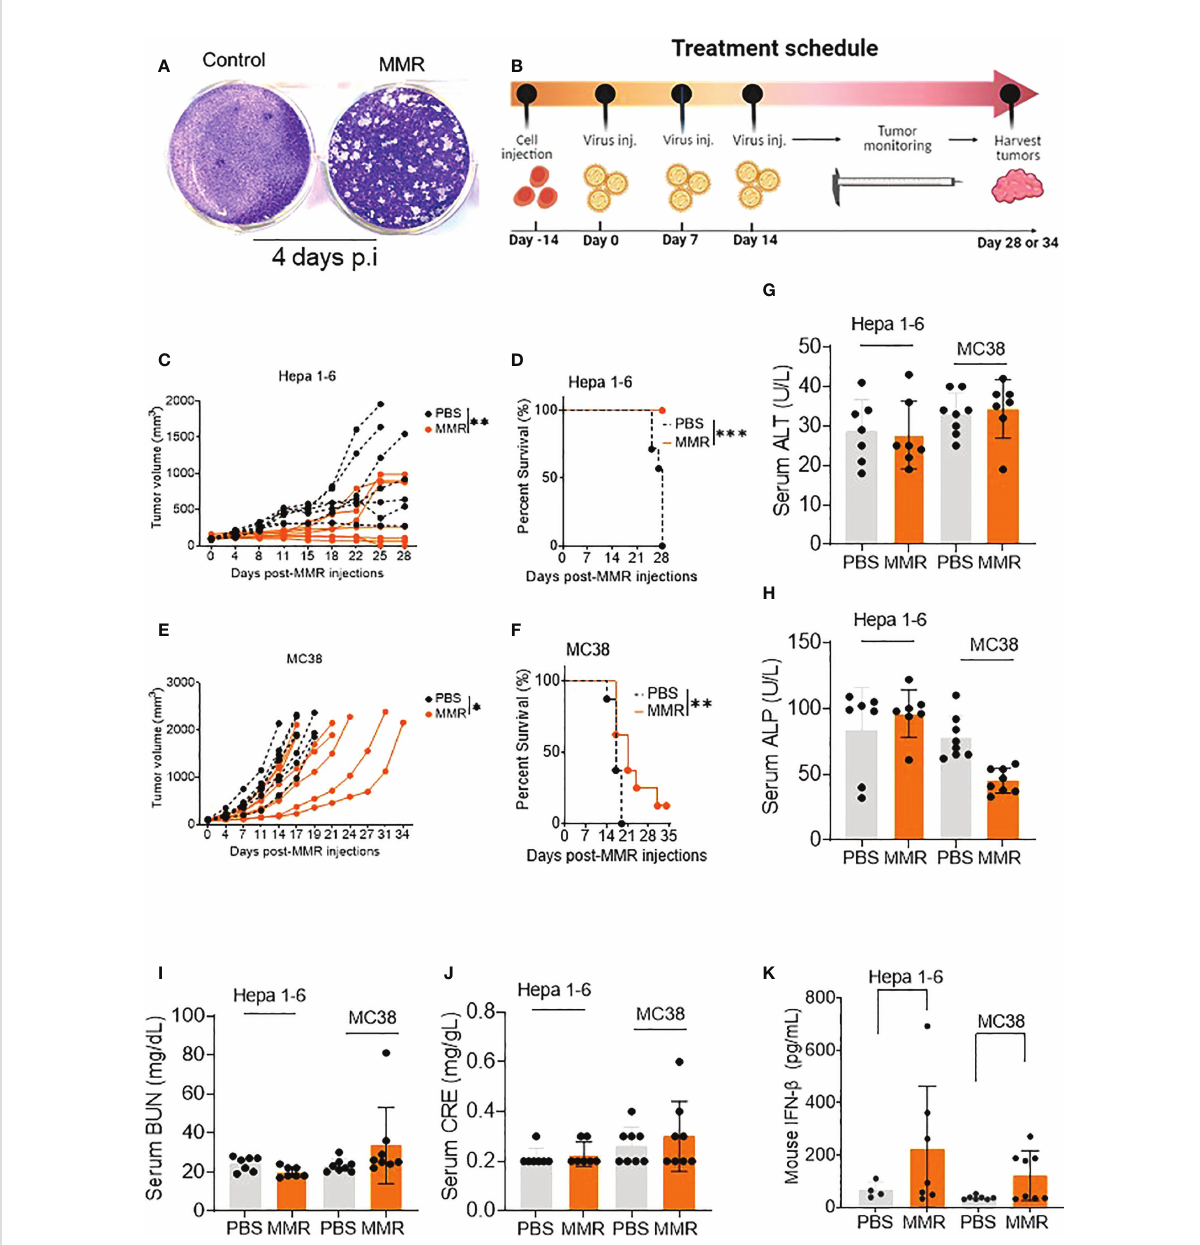
FIGURE 1 IT injections of MMR induce tumor growth delay and improve survival in murine tumor models. (A) A single dose of MMR (1x 102 TCID50) was used to infect a monolayer of Vero cells (2.5 x 105/well in 6-well plates) four days later, cells were stained with crystal violet to reveal infectious viral plaques. (B) In the treatment schedule, at day -14, tumor cells were subcutaneously implanted into the right fl anks of mice, then PBS or MMR was injected into tumor-bearing mice at days 0, 7, and 14. Tumors were harvested at different time points throughout the study. (C – F) Three doses (days 0,7 and 14) of PBS or MMR were intratumorally (IT) administered into mice bearing subcutaneous Hepa 1-6 and MC38 tumors. Individual tumor growth curves are shown (n =7/group [Hepa 1-6] n=8/group [MC38]) (C, E) . Paired t test with and Wilcoxen signedrank test were performed (95% CI), ***P<0.0005, **P<0.005, *P<0.05. The day when we injected the fi rst MMR or PBS into the mice is de fi ned as day 0. Kaplan – Meier survival analysis of subcutaneous Hepa 1-6 and MC38 tumor-bearing mice (D, F) . The statistical signi fi cance of differences in the survival curves between the groups was evaluated using the log-rank (Mantel-Cox) test. (G – J) Mouse Serum biochemical analysis. Serum chemistry analysis of markers of liver and nephrotoxicity. Graphs showing changes in concentration of enzymes such as alanine aminotransferase (ALT, G ), alkaline phosphates (ALP, H ), blood urea nitrogen (BUN, I ), serum creatinine (CRE, J ) between the PBS and MMR- treated groups. (K) Levels of mouse type I interferon b (IFN- b) in serum. Level of antiviral cytokine (IFN- b) was measured in serum from mice treated with MMR or